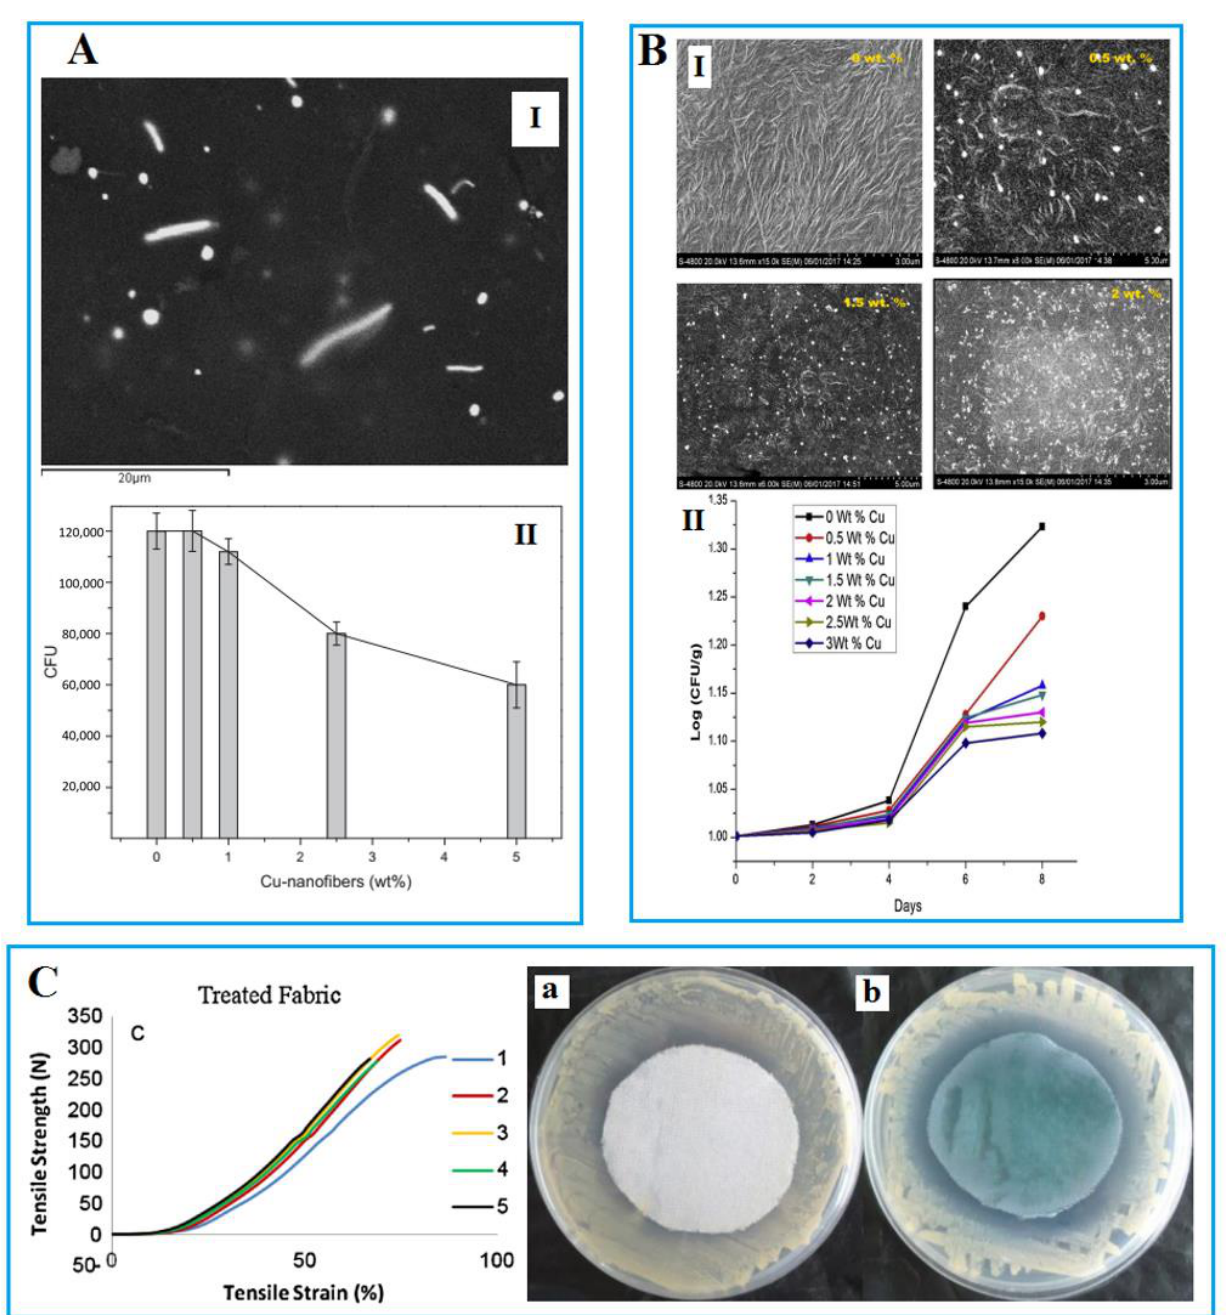
Figure 2. ( A ) I: SEM images of high-density polyethylene (HDPE)/Cu-nanofiber nanocomposites containing 2.5 wt.% Cu-nanofibers; II: The effect of Cu content of HDPE/Cu-nanofiber nanocomposites on the growth of bacterial colonies forming units (CFU). Reprinted with permission from [51]. Copyright 2013 Elsevier. ( B ) I: Pure low-density polyethylene (LDPE) and LDPE/Cu nanocomposite films (0 wt.% scale bar = 3 μm; 0.5 wt.% scale bar = 5 μm; 1.5 wt.% scale bar = 5 μm; 2.0 wt.% scale bar = 3 μm; 2.5 wt.% scale bar = 5 μm; 3 wt.% scale bar = 5 μm); II: The effect of various content of CuNPs on antibacterial activity assay of LDPE/Cu nanocomposite during incubation time of 24 h. Reprinted with permission [12]. Copyright 2018 Elsevier. ( C ) As CuNPs content increased in concentration, the value of CFU (number of microorganisms) decreased. Reprinted with permission from [12]. ( C ) (left): Diagrams of strength–strain obtained with Instron for treated fabrics; (right): Disk-diffusion test against S. aureus microbial growth for ( a ) untreated nylon fabric ( b ) CuNPs treated nylon fabric. Reprinted with permission from [57]. Copyright 2013 Elsevier.